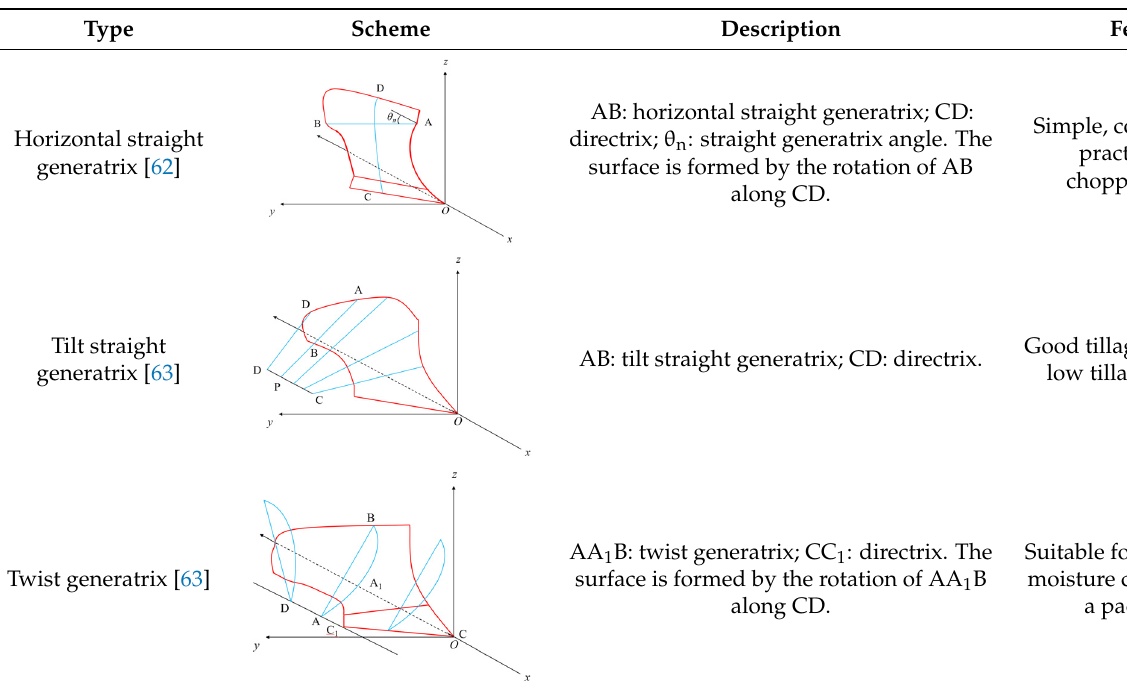
Table 10. Features of different types of moldboards.